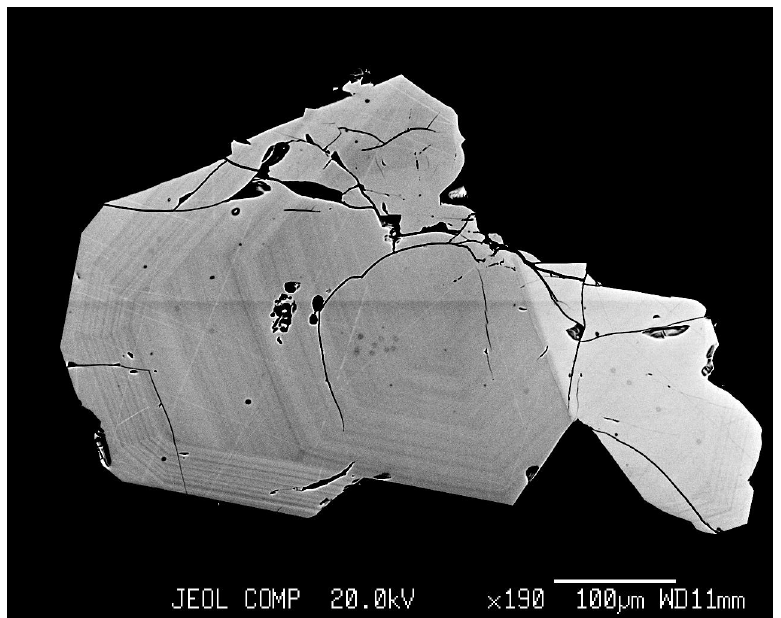
Figure 3. The scanning image in back scattered electrons (BSEs) of magnetite crystal (Experiment 8, Table 1). Note the homogeneity in elements’ distribution inside of a cry stal.